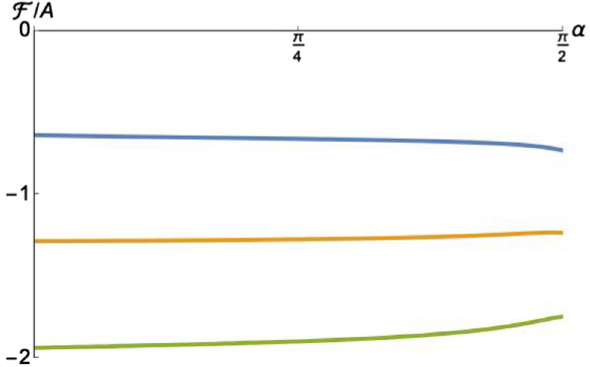
Fig. 10 F / A for U ∈ M ( 0 ) at high temperatures: T = 1 . 35 (blue F line), T = 1 . 65 (yellow line), and T = 1 . 85 (green line)